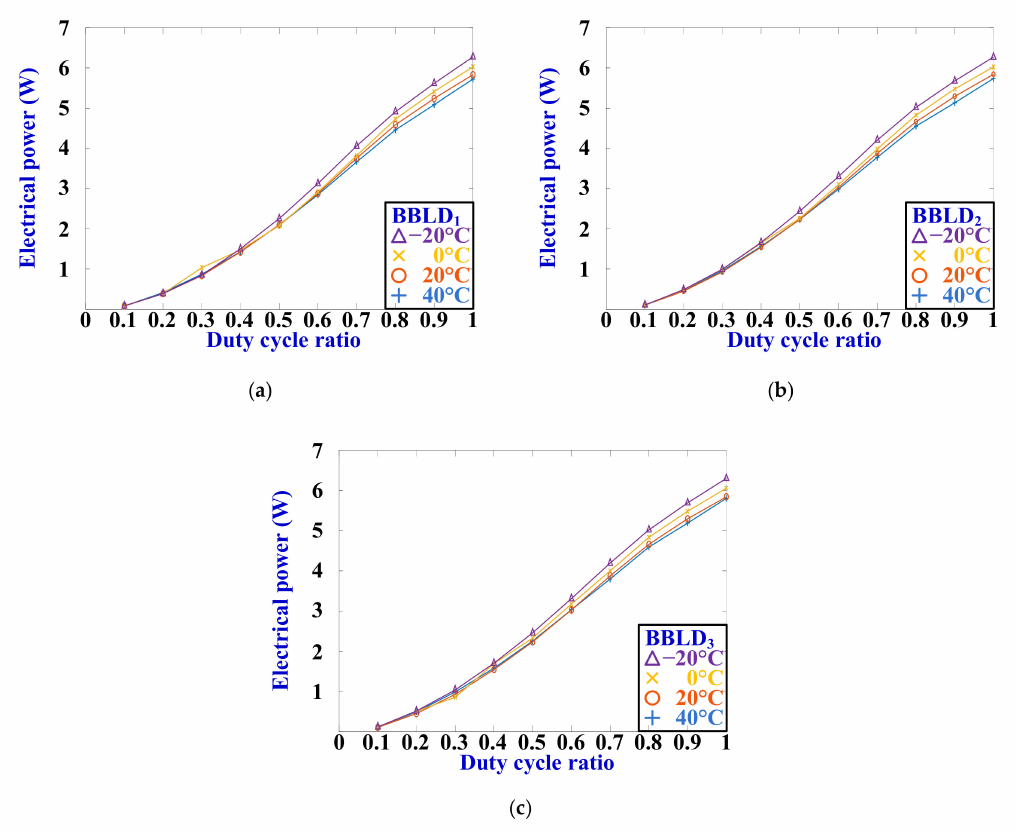
Figure 12. Variation of D pdcm to electrical power ( P e ( pdcm _ mean ) ) using mean-value calculation ( f s = 400 Hz). ( a ) BBLD 1 . ( b ) BBLD 2 . ( c ) BBLD 3 .